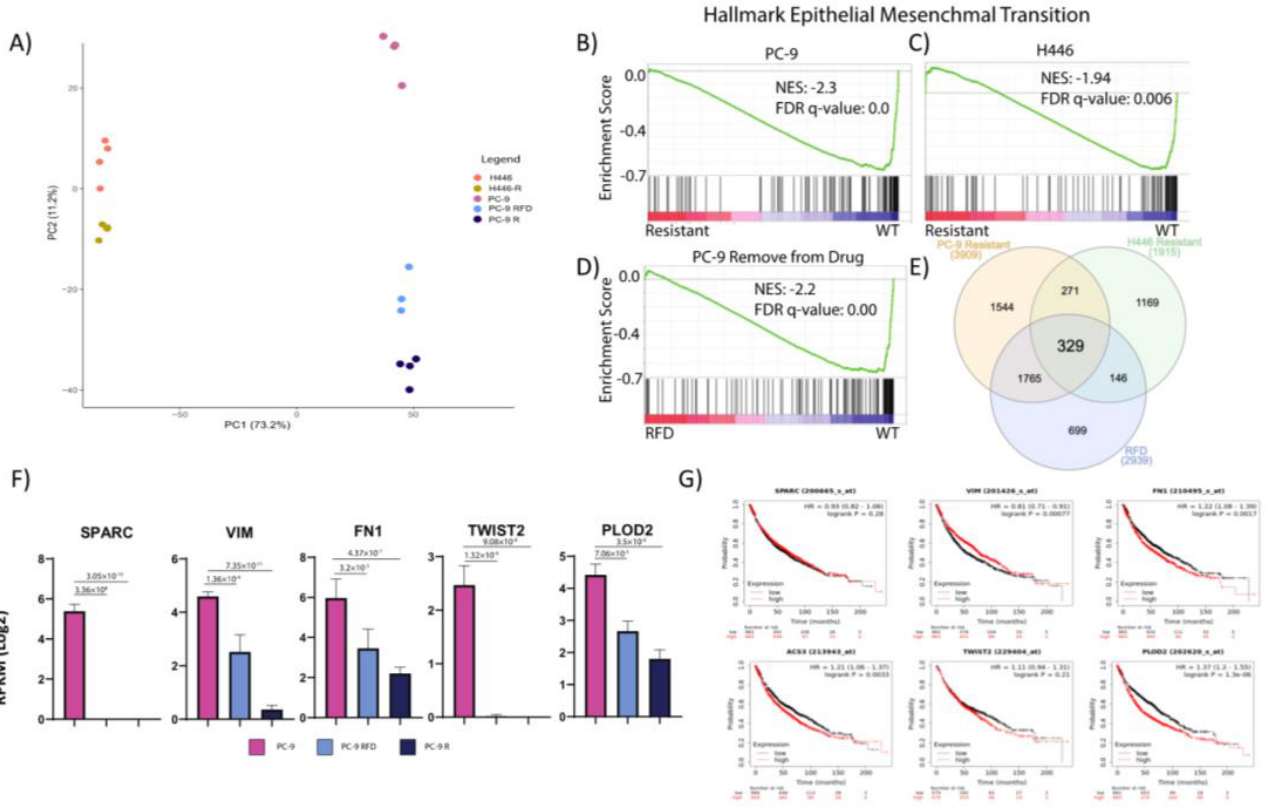
Figure 2. Transcriptome analysis indicated a downregulation in EMT in MTI-101-resistant lines. ( A ) PCA plot of all cell lines based on gene expression. ( B – D ) GSEA analysis of genes sorted based on fold changes in PC-9R vs. PC-9 ( B ), H446-R vs. H446 ( C ) or PC-9R RFD vs. PC-9 ( D ) from high (red) to low (blue) against MSigDB hallmark gene set “epithelial mesenchymal transition” (vertical bars). NES: normalized enriched score. ( E ) Venn diagram analysis of DE genes predicted for each resistance lines vs. corresponding WT. ( F ) Bar plot for expression values of SPARC, VIM, FN1, TWIST2 and PLOD2 across PC-9, RFD and PC-9R; FDR for differential expression from EdgeR indicated. ( G ) Individual genes (SPARC, VIM, FN1, ACS3/TWIST1, TWIST2 and PLOD2) split by median on all lung cancer patient data and predicted clinical prognosis in lung cancer. TWIST1 (ACS3), FN1 and PLOD2 are poor prognostic indicators for clinical outcome in lung cancer.